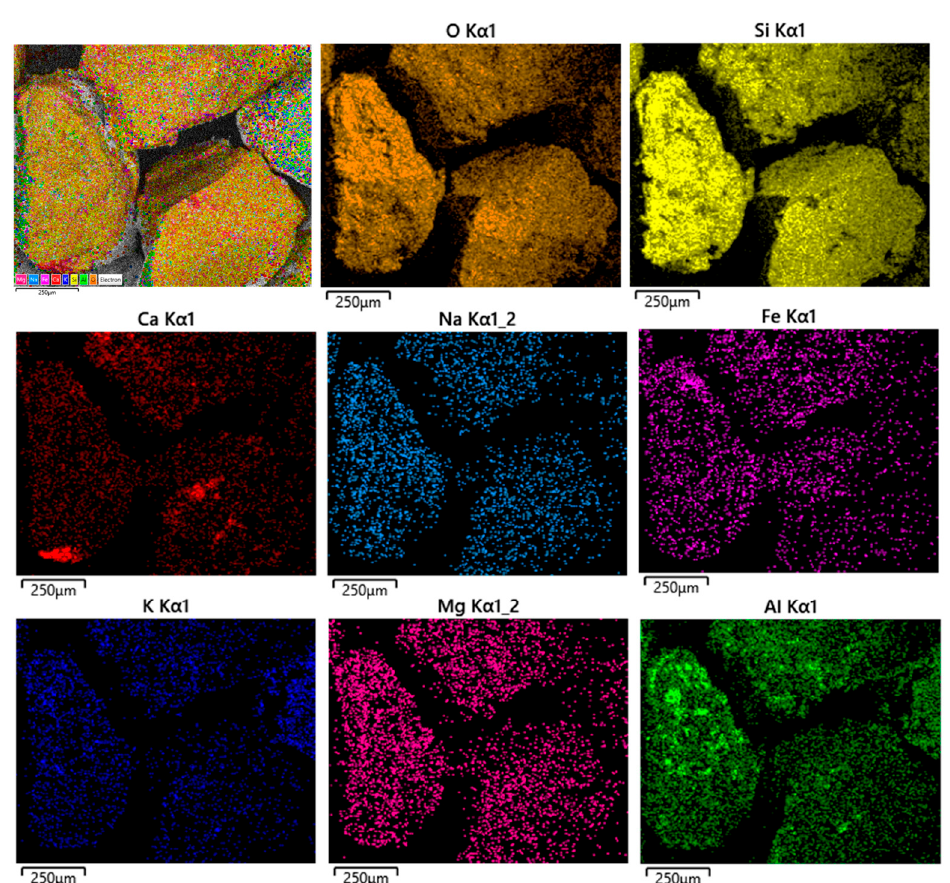
Figure 4. Elemental distribution maps for the quartz particle size ranging between 500 and 630 µ m.